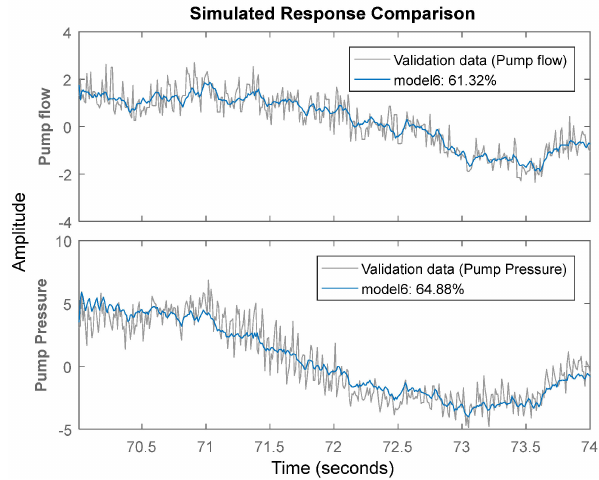
Figure 5. Comparison between the model simulated output and the identification data set.